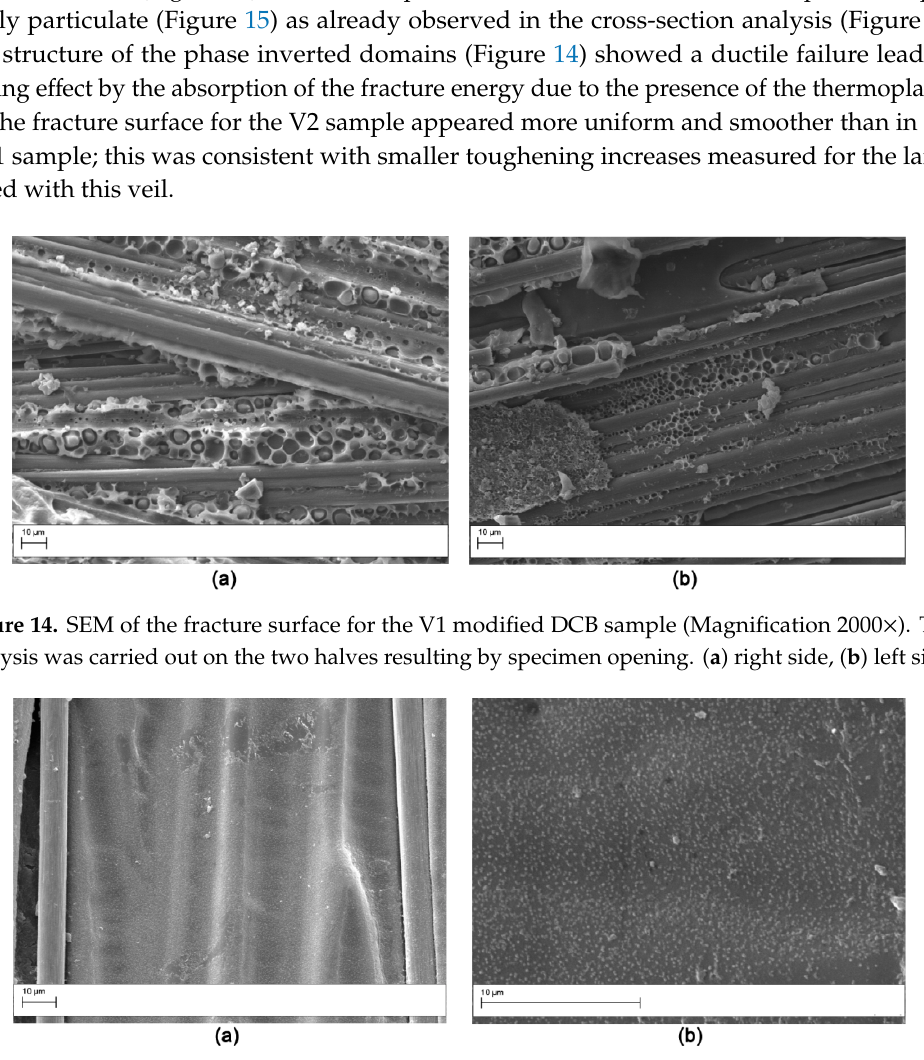
Figure 13. SEM of the fracture surface for the OV modified DCB sample: low magnification (50×) ( a ); high magnification (200×) ( b ).